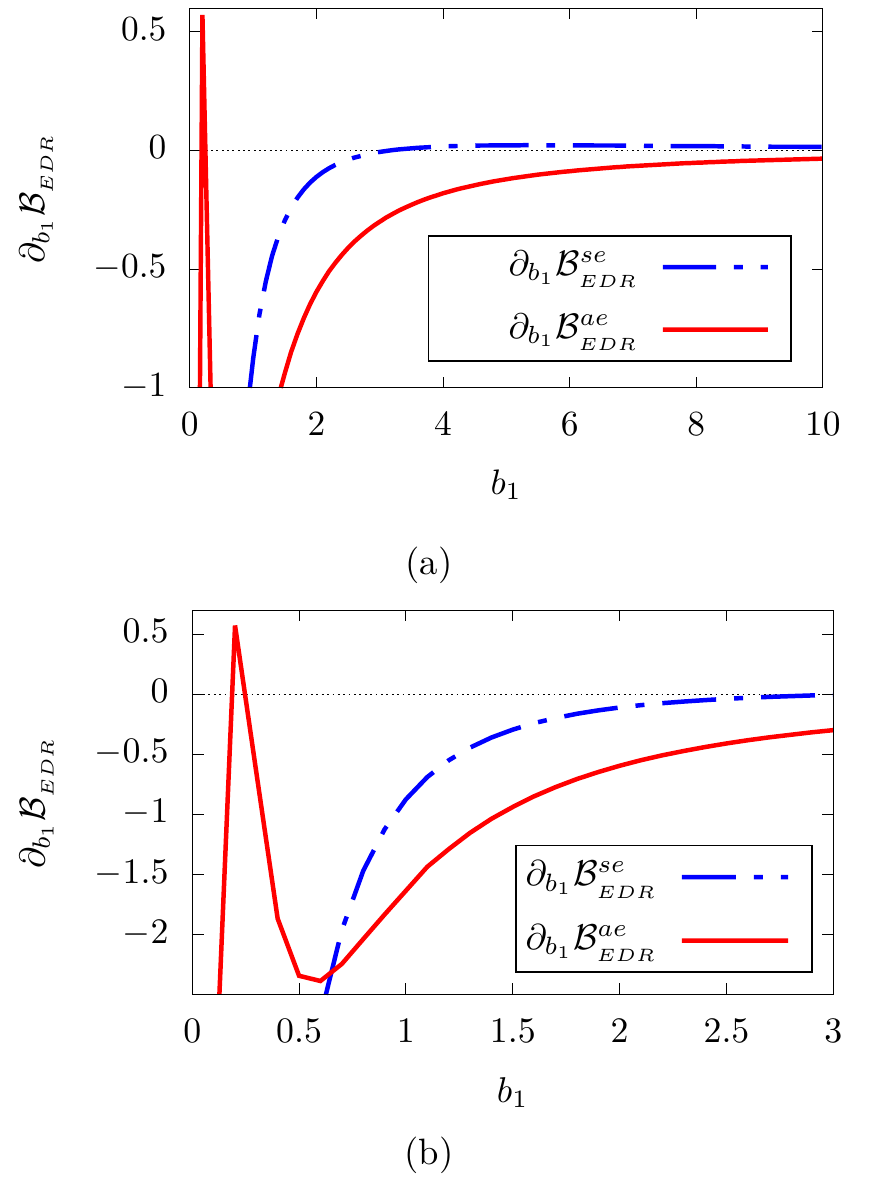
Figure 11 . (a) The quantity ∂ b B se is plotted with respect to varying b 1 for accelerated atoms 1 EDR in thermal background in (1 + 3) dimensions, depicted by dash-dotted blue line. The quantity ∂ b B ae is plotted with respect to varying b 1 for accelerated atoms in thermal background in 1 EDR (1 + 3) dimensions, depicted by solid red line. (b) The same plot as depicted in the previous sub- figure with the x − range in the initial region now